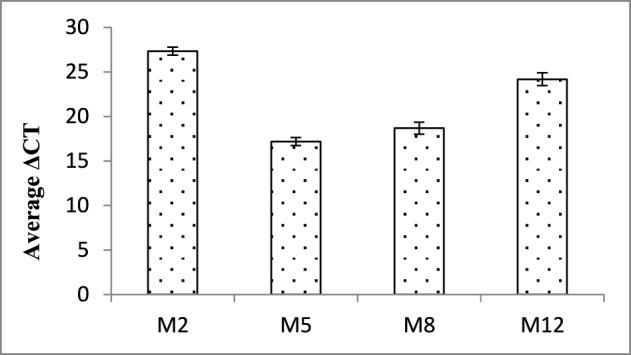
Expression analysis of Mi-cpl-1 gene in T1 plants. ΔCT values were calculated using the difference in the Ct mean of Mi-cpl-1 and 18S rRNA gene. Each bar represents the mean ±SE of n = 3.